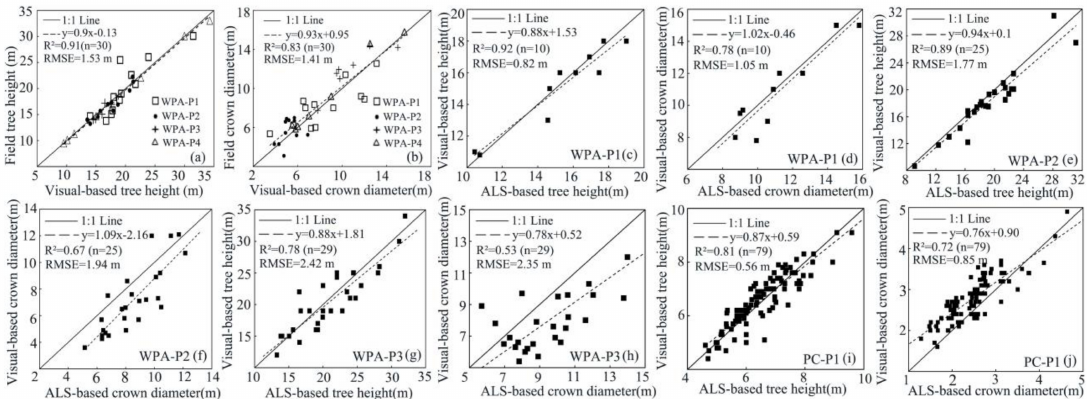
Figure 3. Comparisons between the visual- and field-based tree heights (a) and crown diameters (b) in the WPA site. The verified visual-based tree heights and crown diameters were used to validate the ones obtained from the ALS-based method in both WPA (WPA-P1, WPA-P2, WPA-P3) (insets c–h ) and PC (PC-P1) (insets i and j )